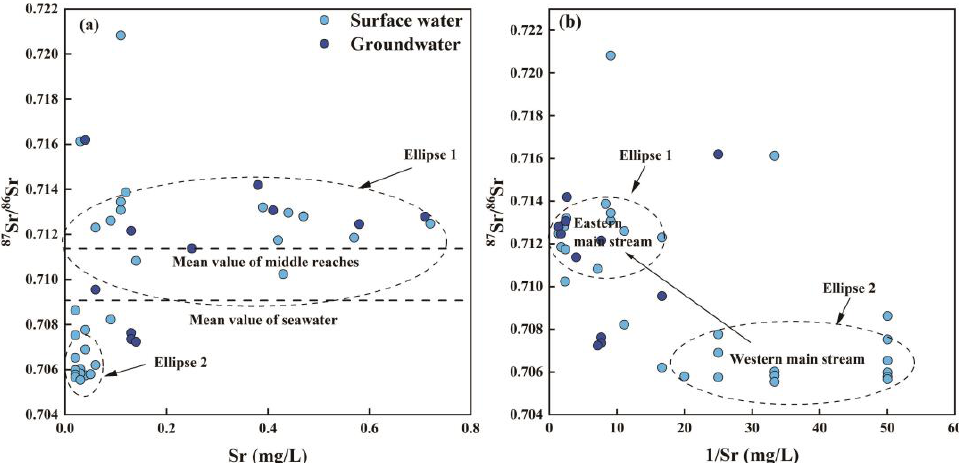
Figure 12. 87 Sr/ 86 Sr vs. Sr ( a ) and 87 Sr/ 86 Sr vs. 1/Sr ( b ) of surface water and groundwater samples in the lower reaches of the Yarlung Zangbo River. Data were from Tables 1 and 2.